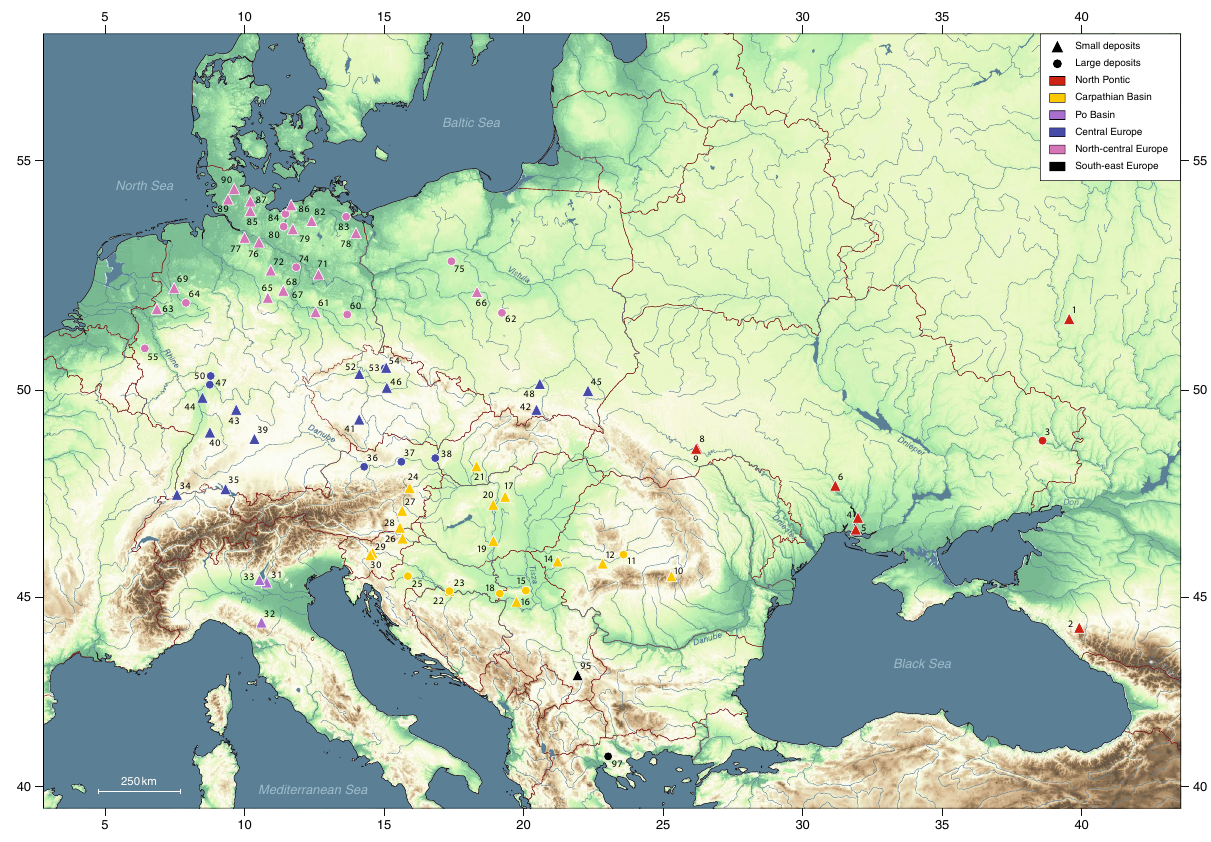
Figure 3. Location of the 80 sites, with small and/or large millet deposits, included in the model and assigned to broad geographical regions within which the results are discussed; see Fig. 1 caption for site names (site #4, Dikiy Sad, which yielded both small and large millet deposit, is here classified as large).[Map generated using the software: QGIS 3.10.5—A Coruña (https ://qgis.org); copyright by OpenStreetMap contributors, terrestris GmbH & Co KG (https ://www.terre stris .de), and Natural Earth Data (https ://www.natur alear thdat a.com)].